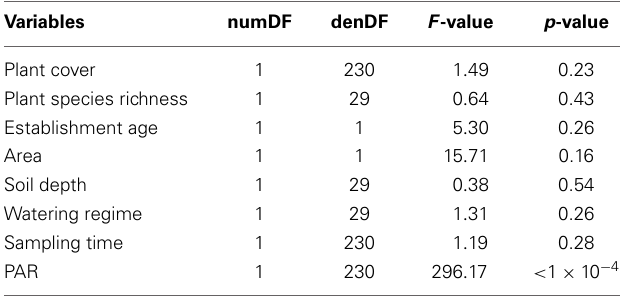
Table 3 | Results from a Wald test of a linear mixed effect model with the response variable assimilation rate to assess the significance of the fixed effects (i.e., PAR, sampling times, watering regime, soil depth, area, establishment age, plant species richness, and plant cover) on a linear mixed effects model for plant CO 2 assimilation